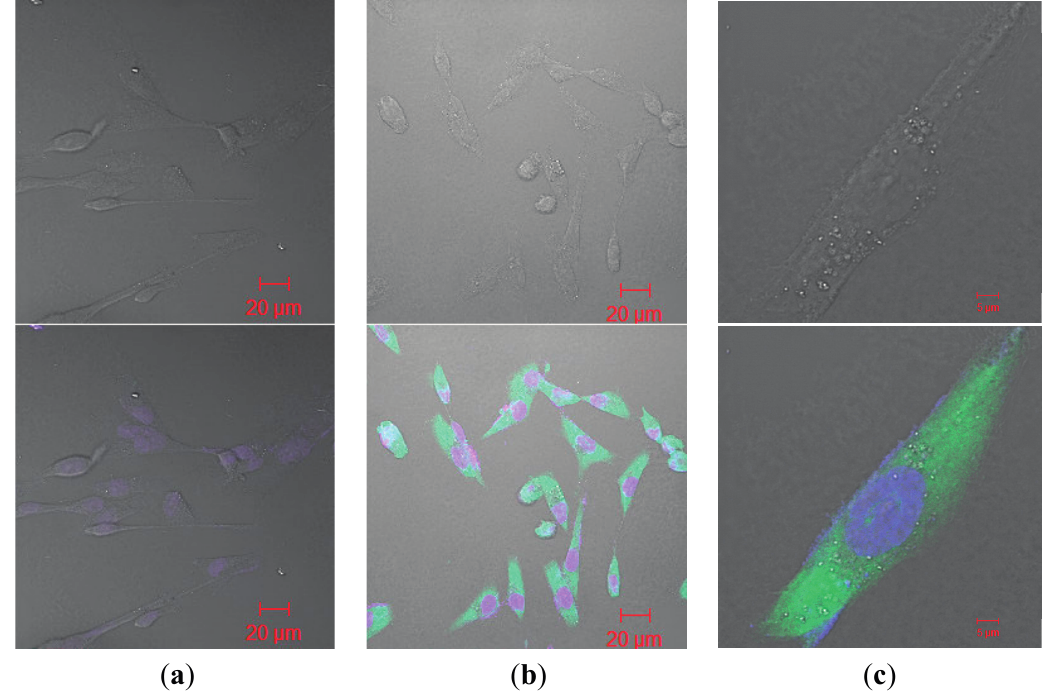
Figure 2. Immunofluorescence of released anti-AnxA2 antibody from nanoparticle ( a ) MDAMB 231 cells treated with heat inactivated anti-AnxA2 antibody released from nanoparticle; ( b ) Lower magnification of MDAMB 231 cells treated with anti-AnxA2 antibody released from nanoparticles; ( c ) Higher magnification of single MDAMB 231 cell treated with released anti-AnxA2 antibody. Green = Alexa fluor 488 tagged secondary antibody. Blue =